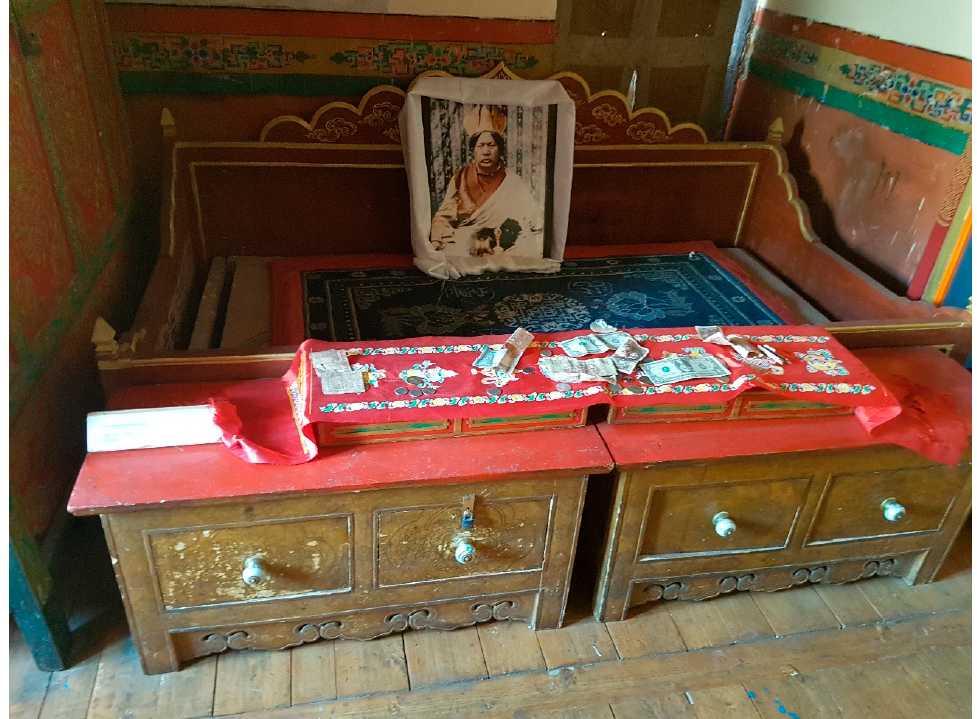
Figure 10. Photo of Taktsang Repa, Chemde Monastery Museum, Ladakh (photo L. Tythacott 2017). Consecrated Tibetan objects are considered to be fundamentally the same in these Himalayan monasteries whether on display in a temple surrounded by offerings or individualised in these new museums surrounded by interpretative text. It is possible to move a consecrated Buddhist statue from the reverential location of an altar in a temple, across an open courtyard, to a museum exhibition on the other side of a monastery, without needing de-consecration or re-consecration ceremonies. All that is required in Tibetan Buddhist practice is the right mindset. Such objects thus continue to